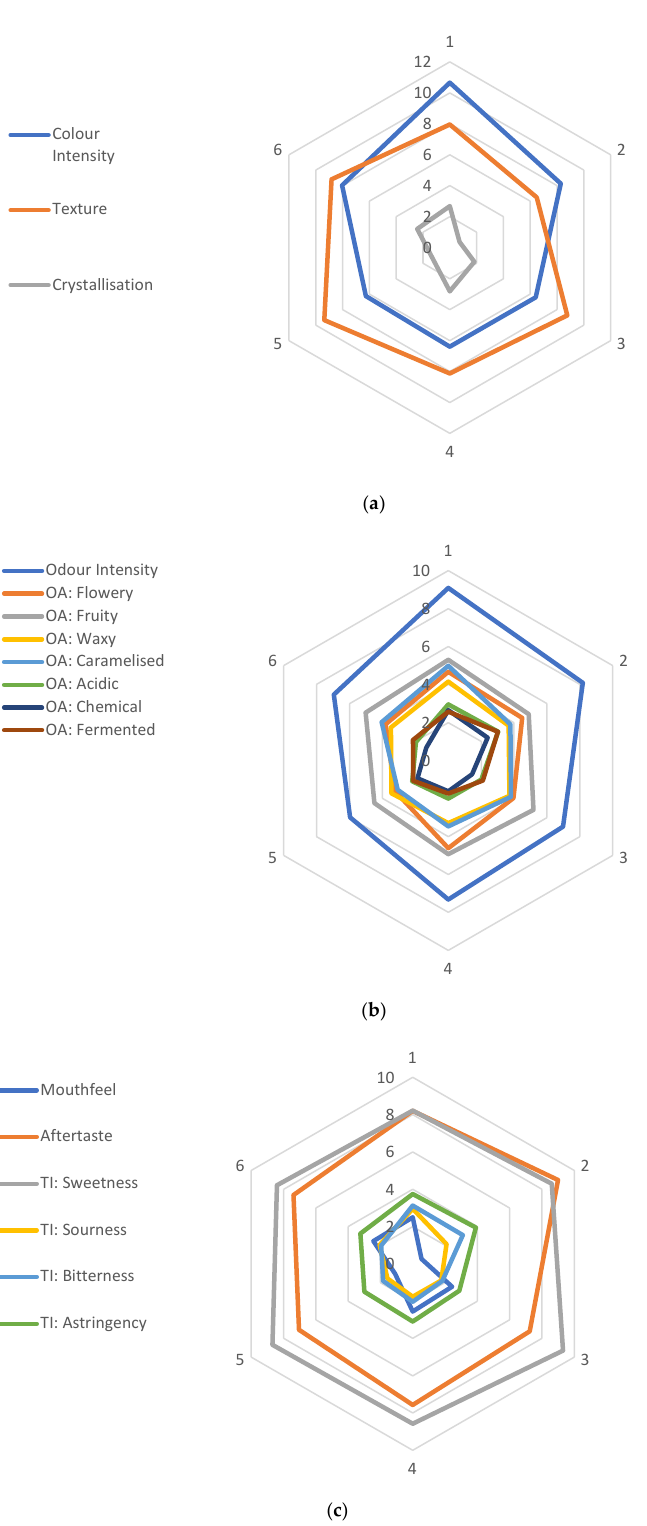
Figure 1. The mean values for the honey sensory analysis (honey sample n = 32; each sensory property assessed once). Note: ( a ) = visual characteristics; ( b ) = olfactory characteristics; ( c ) = taste characteristics. The external numbers represent the honey categories where the mean value for each sensory attribute based on panellist response ( n = 24) is represented; 1 = Manuka Honey; 2 = Organic Honey; 3 = Generic Brand Honey; 4 = Australian Floral Honey; 5 = Regional Honey; 6 = Pure Honey. Internal numbers represent the rating scale (cm) of the sensory analysis, with each colour representing a different attribute.